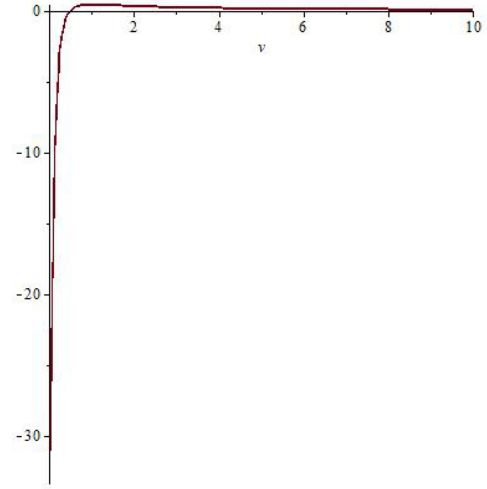
Figure 3. Second adjoint variable.